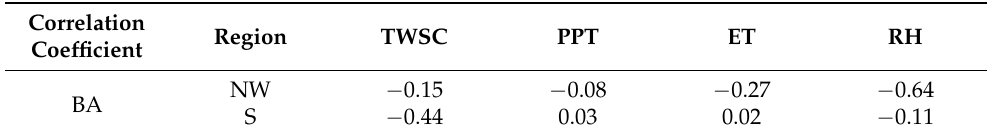
Table 5. The correlation coefficients between burned area (BA), PPT, ET, relative humidity (RH) and TWSC on the interannual scale in region NW and S.